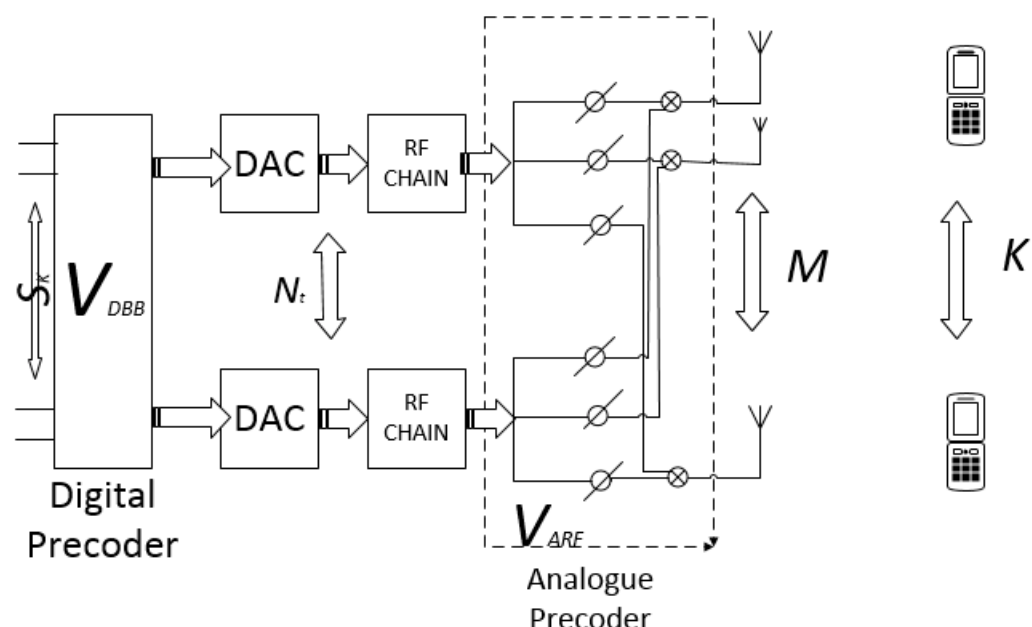
Figure 1. Millimeter wave massive MIMO.